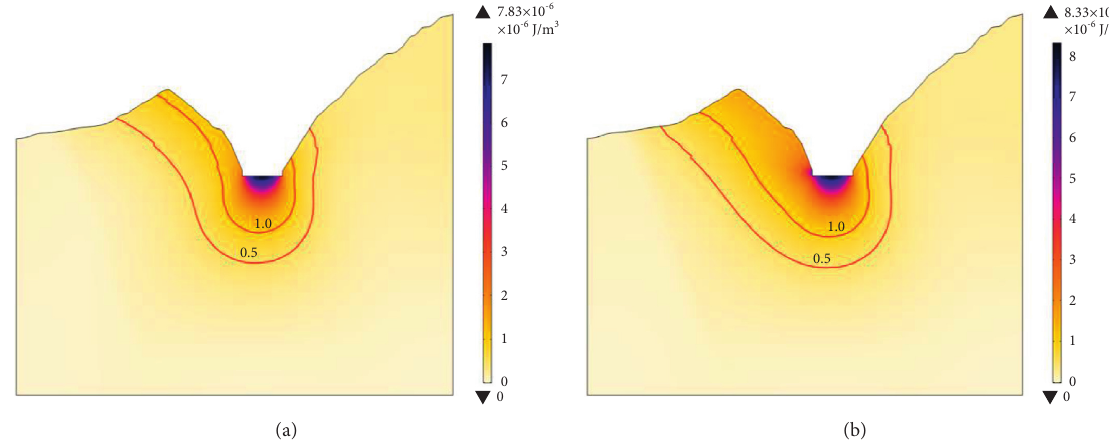
Figure 10: Distribution of the time-average kinetic energy